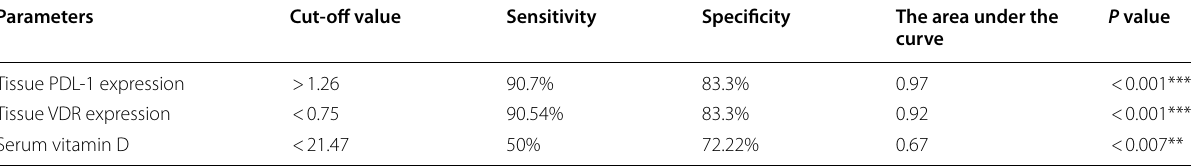
Table 3 Cut‑off values, sensitivity, specificity, and area under the curve of the different studied parameters in lung cancer